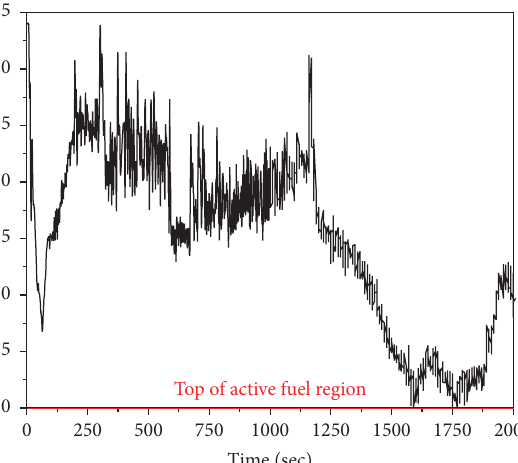
Figure 8: Comparison of pressure drop in case-1 and case-2.